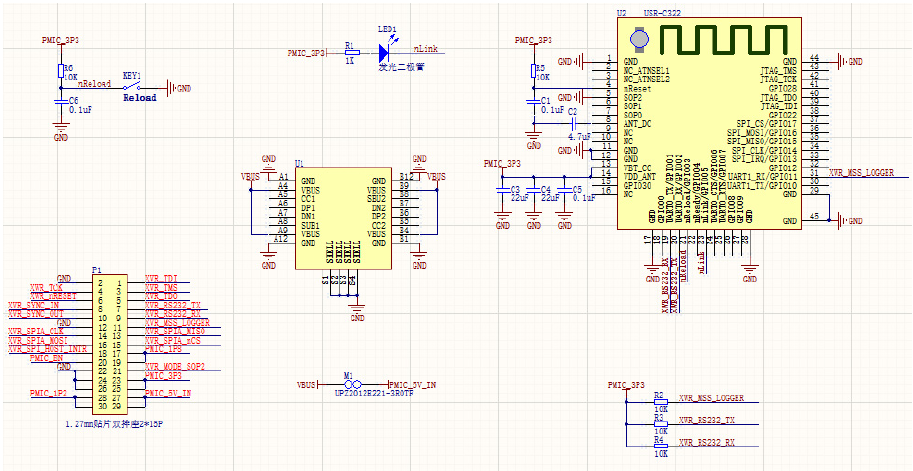
Figure 7. The schematic diagram of the WIFI communication circuit. Figure 7 is the schematic diagram of the circuit, the WIFI circuit board and the radar board were connected by connecting pins, on which power supply and UART serial port transmission were integrated.